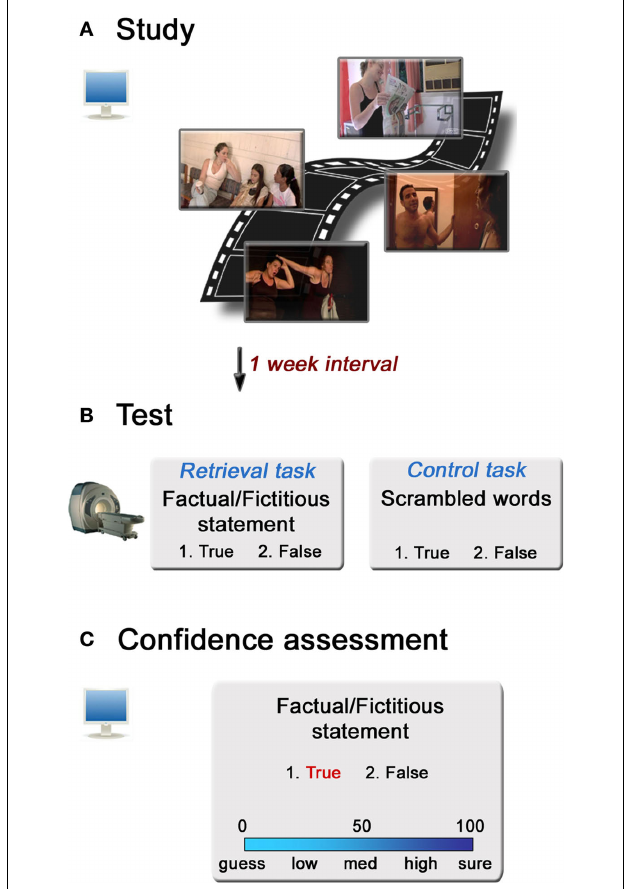
FIGURE 1 | Experimental design. (A) The Study session consisted of watching a 45-min documentary fi lm in a quiet room. (B) One week after the Study session, participants performed a Test session while undergoing an fMRI brain scan. Each retrieval-task trial included either a Factual or Fictitious statement regarding events in the movie, to which participants responded either true or false. In the control task, scrambled letters were presented, for which the task was to identify the appearance of certain letter types in the phrase (see Materials and Methods for further details). (C) Immediately following the fMRI session, participants were instructed to rate their confi dence on a Visual Analogue Scale (VAS) ranging from 0 to 100 regarding their retrieval success on each answer provided during Test . This was performed in a quiet room in front of a computer